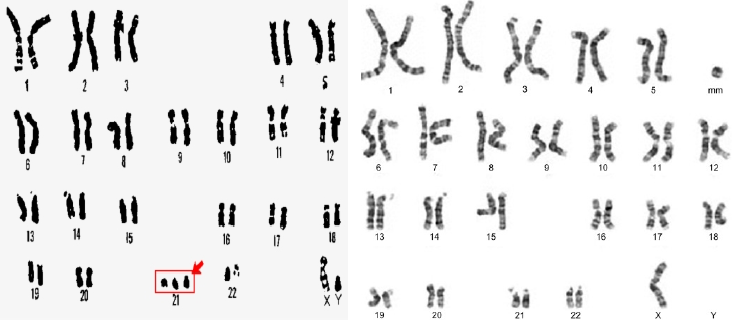
Figure 3. Examples of aneuploidy with Trisomy 21 showing an extra chromosome 21 ( left ) and Turner’s syndrome with missing genes from the short arm of the X chromosome ( right ).